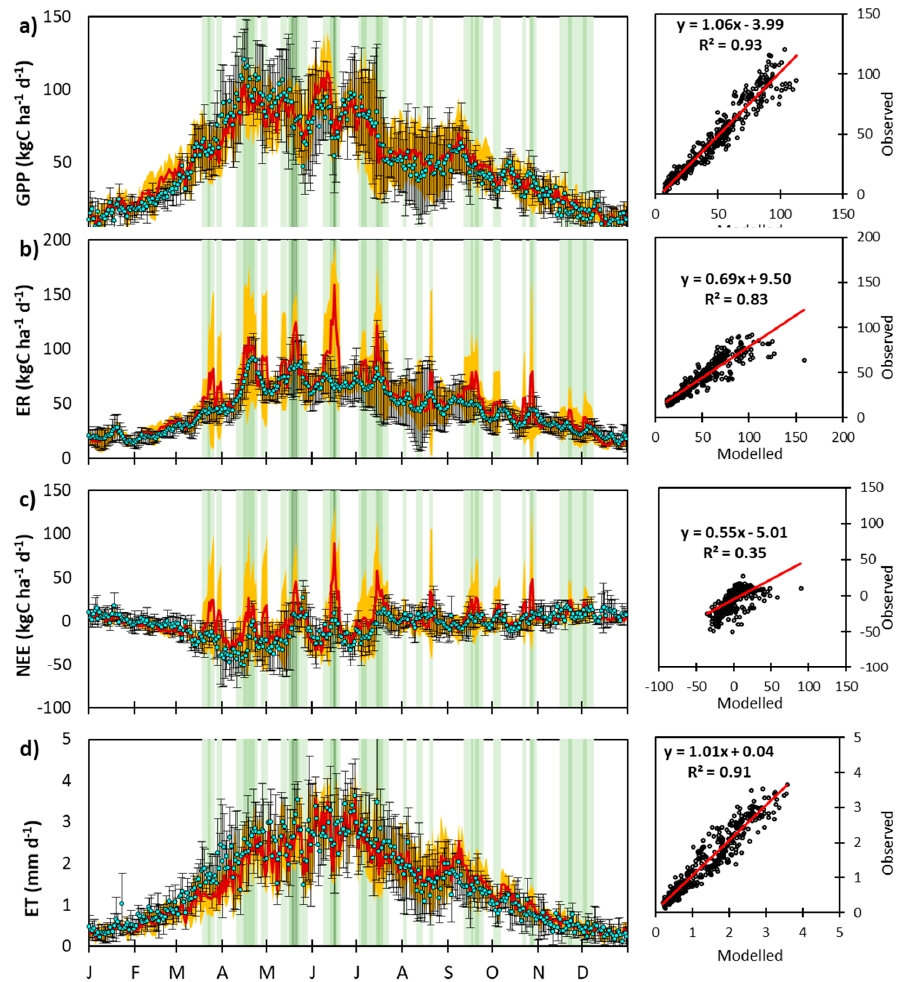
Figure 9. Daily carbon and water fluxes averaged for each day of the year over the study period (2006–2010) for the grazed pasture. Blue circles are used for observations, error bars represent one standard deviation around observed means; the red line is used for CenW modeled fluxes; and the yellow shaded areas represent one standard deviation around modeled means. GPP ( a ), ER ( b ), NEE ( c ), and ET ( d ).